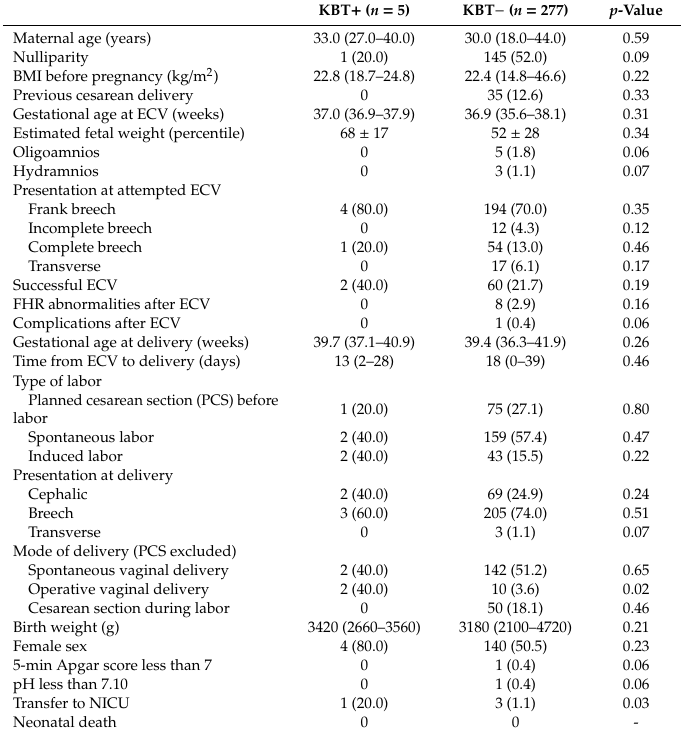
Table 1. Maternal and labor characteristics and neonatal outcomes according to Kleihauer–Betke test result after attempted external cephalic version for a breech presentation at term. KBT + ( n = 5) KBT − ( n =